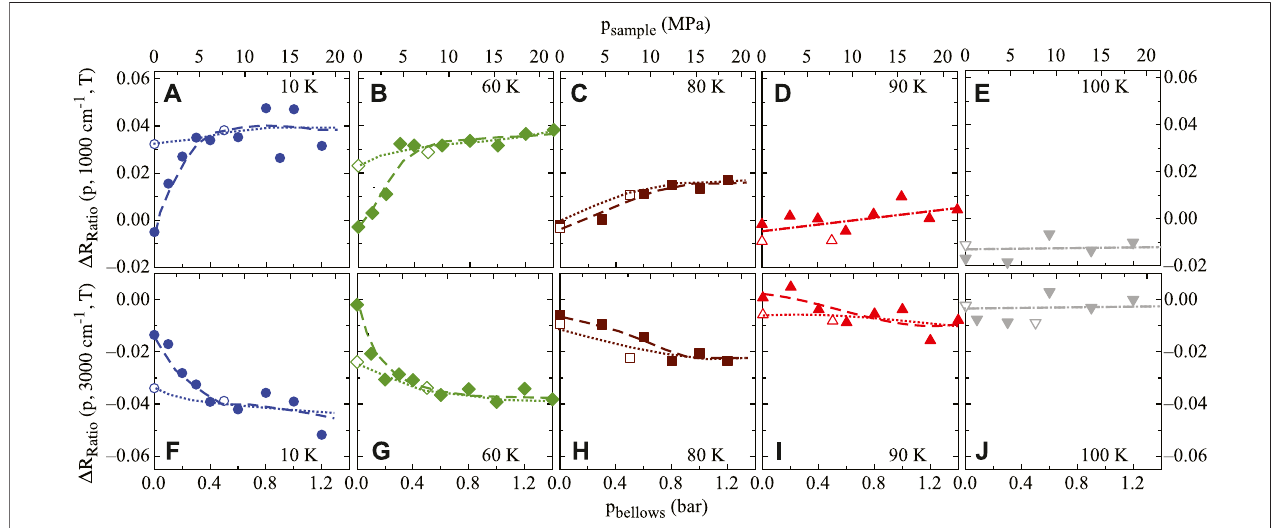
FIGURE 3 | (color online) Optical anisotropy given by Δ R ratio (see text) read at (A – E) 1,000 and (F – J) 3,000 cm − 1 (dashed vertical lines in Figure 2A ) of FeSe as a functionofappliedstress p atrepresentative T :fullandopensymbolsdenoteincreasinganddecreasing p ,respectively,for p -loopmeasurementsfollowinganinitialZPC protocol.Lower x -axisdenotesHe-gas p inthespringbellows( p bellows )andupper x -axistheeffectivestressfeltbythesample( p sample ).Dashed(increasing p )anddotted (releasing p ) lines are drawn to guide the eye. Reproduced from Ref. [25].